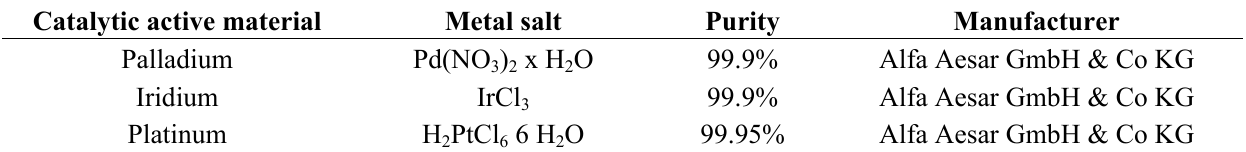
Table 1. Used chemicals for catalyst preparation.